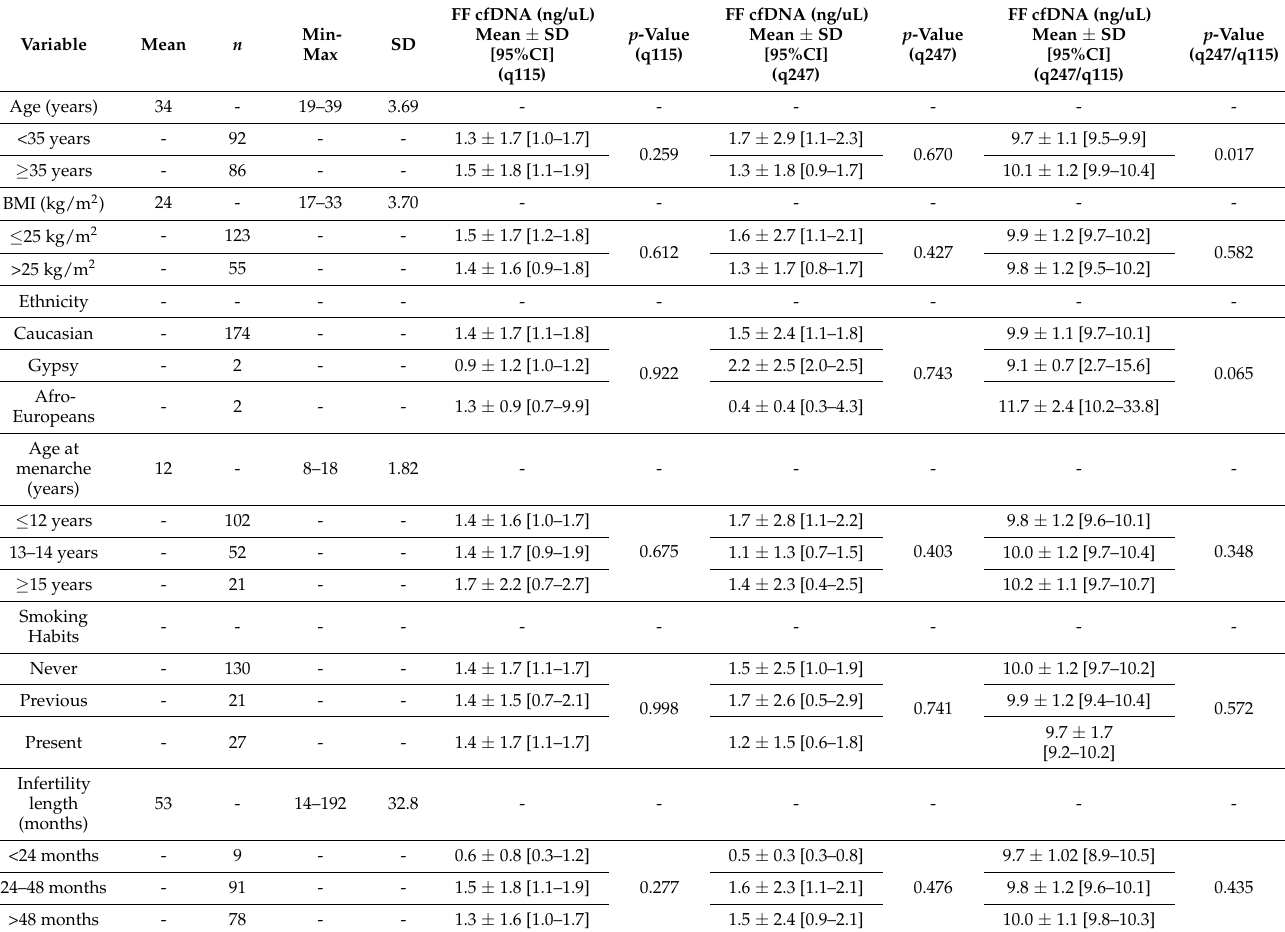
Table 1. Cell-free DNA levels according to age, BMI, ethnicity, age at menarche, smoking habits and infertility